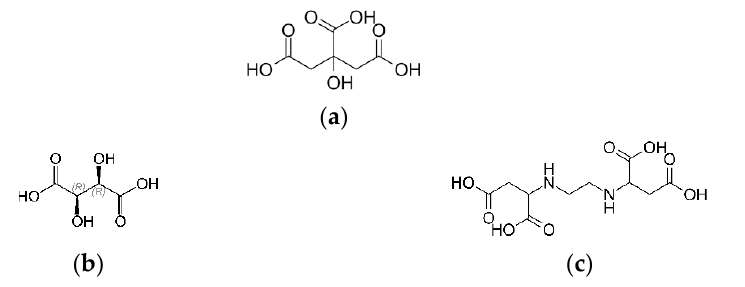
Figure 4. The ( a ) Citric, ( b ) Metatartaric, and ( c ) Ethylenediaminedisuccinic acids.